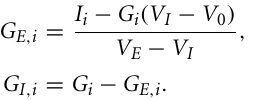
FIGURE 2 | Spontaneous spiking and the activity in firing-clamp regime during GABA application. Recordings were from the same neuron as in Figure 1 . (A) Membrane voltage with occasional spontaneous spikes during